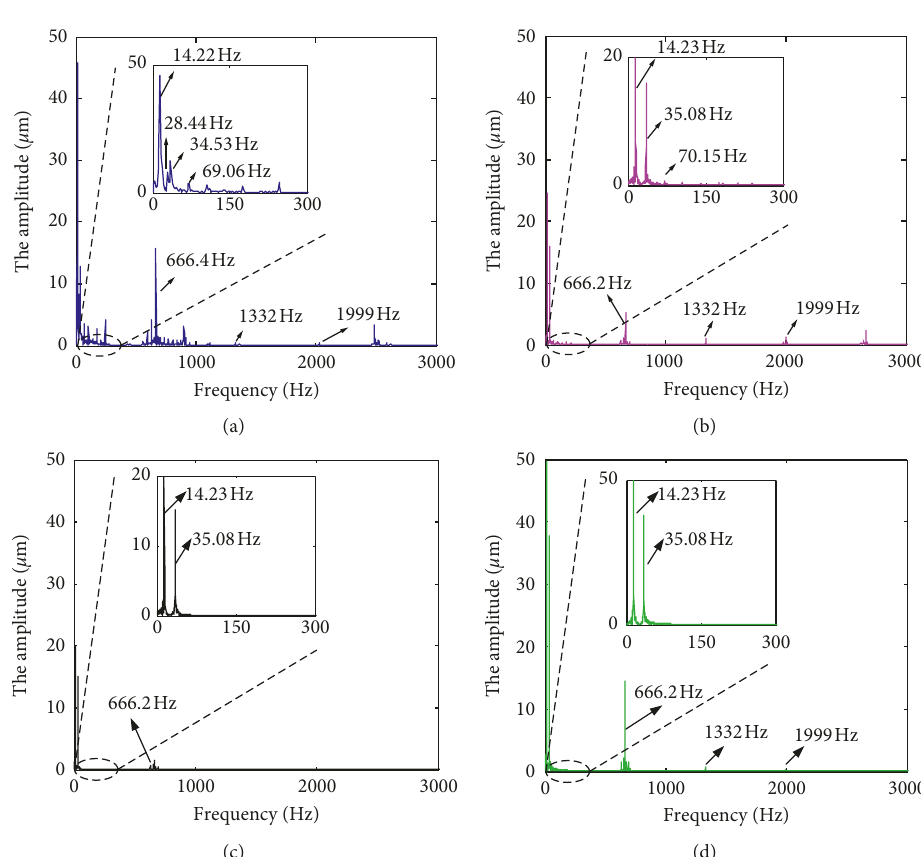
Figure 23: Spectrum and partial enlarged view of dynamic transmission error: (a) experiment; (b) the measured manufacturing errors; (c) no manufacturing errors; (d) the given manufacturing